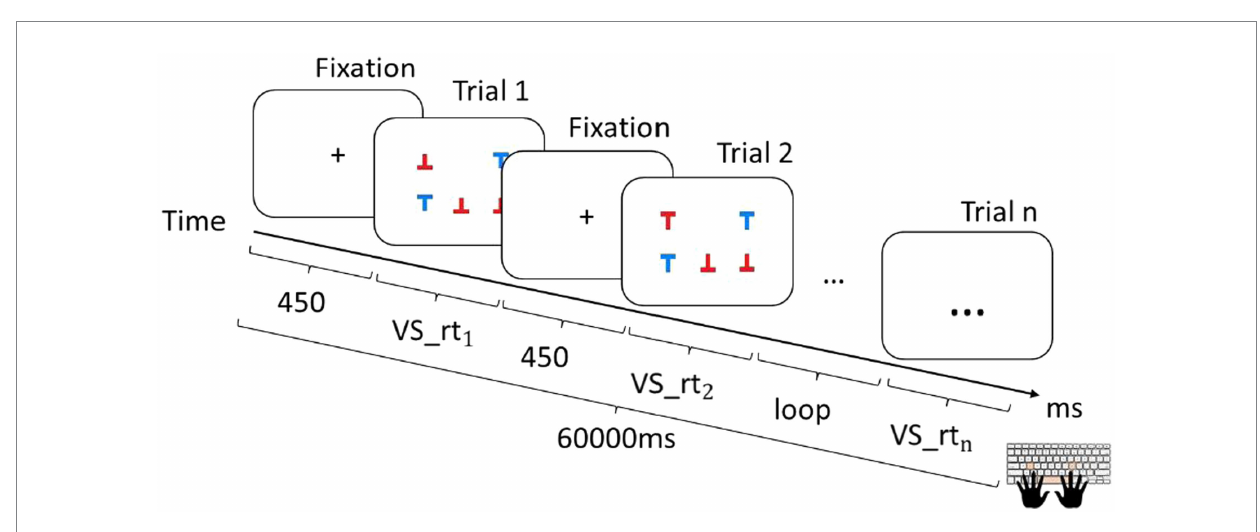
FIGURE 2 Trial sequence of the VS task. rt, reaction